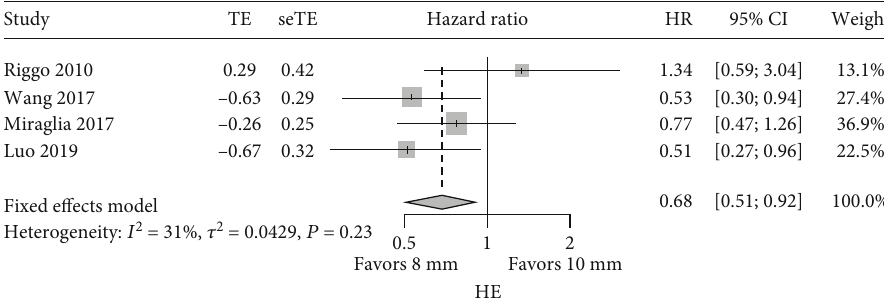
Figure 2: Meta-analysis of HR of HE: 8 mm vs. 10 mm.